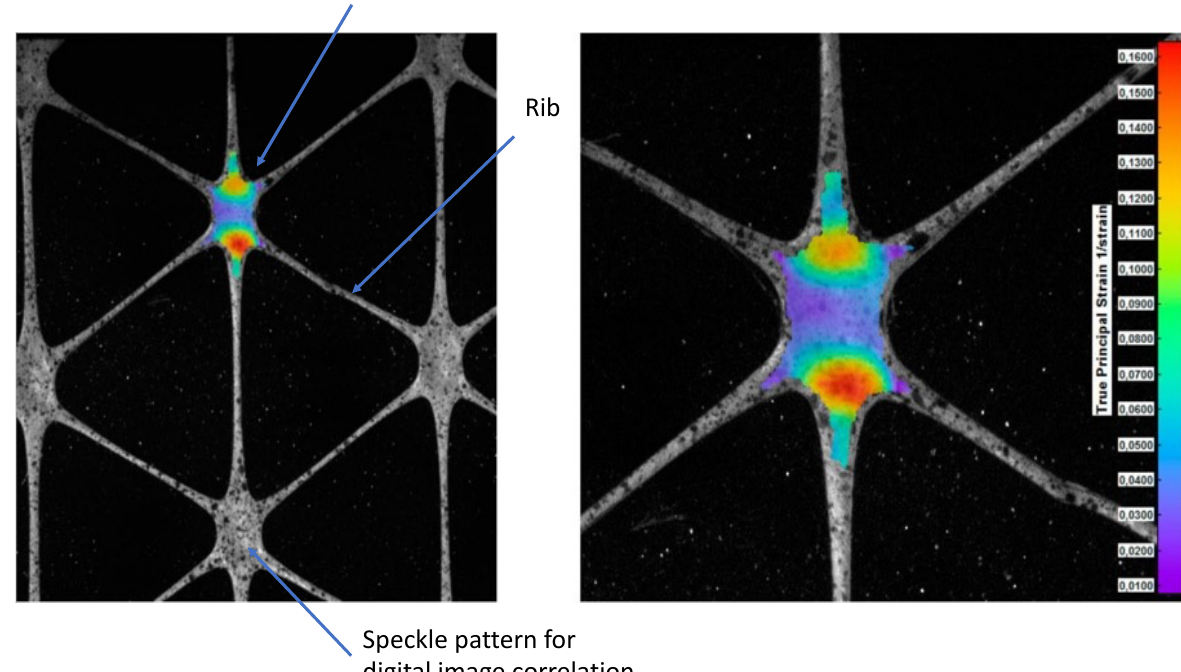
Figure 6. Geogrid components showing stress results from digital image correlation from ref. [101].